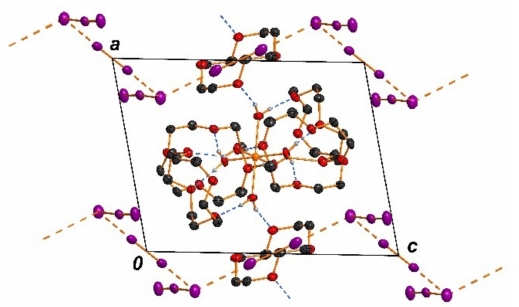
Figure 5. [Cu(12-crown-4) 5 (H 2 O) 6 ]I 6 · 2I 2 . Showing the interlock between hexaaquacopper(II) complex encapsulated by 12-crown-4 molecules (center of the unit cell) and the polymeric polyiodide substructure ( bc plane).